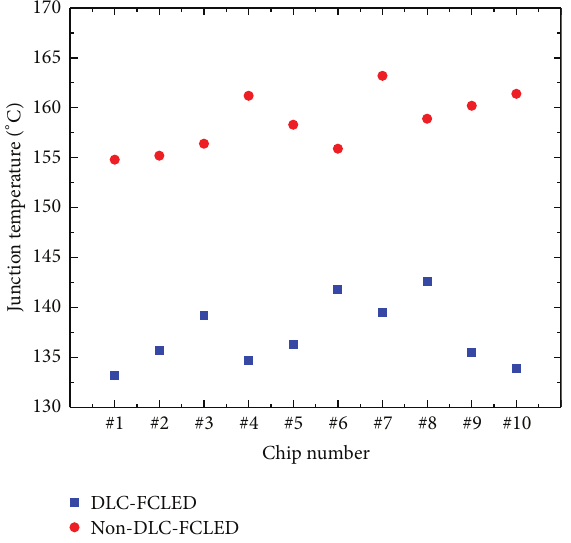
Figure 7: Junction temperature measurements for 10 DLC-FCLED and 10 non-DLC-FCLED chips at an injection current of 1000mA. The chips were randomly